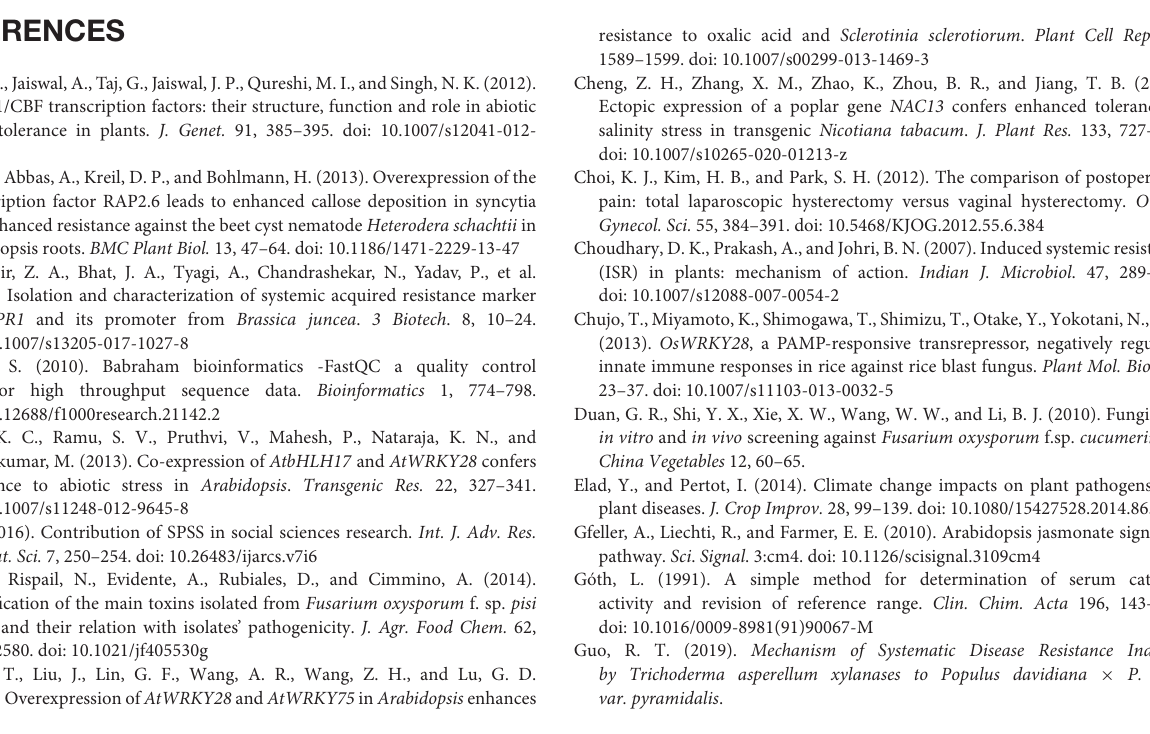
Supplementary Table 4 | Primer sequences of quantitative real-time PCR (PCR). Supplementary Table 5 | Components of PCR amplifications.